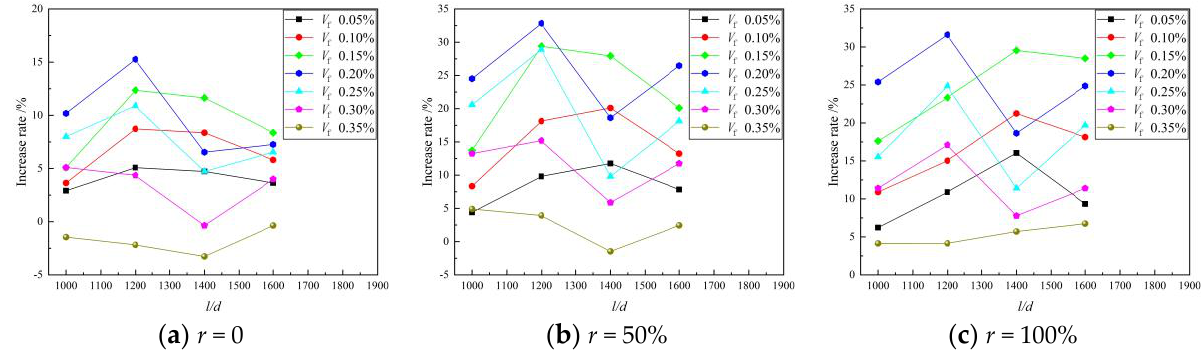
Figure 8. Relationship between BFRAC splitting tensile strength and BF length – diameter ratio.